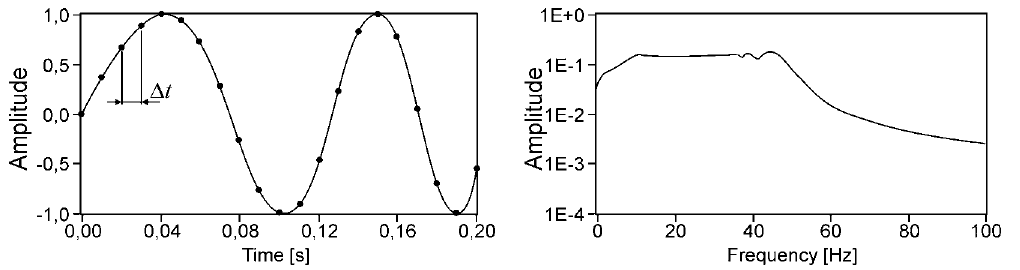
Fig. 1. Waveform and spectrum of a rotor’s variable speed vibration sampled at constant increments of time.